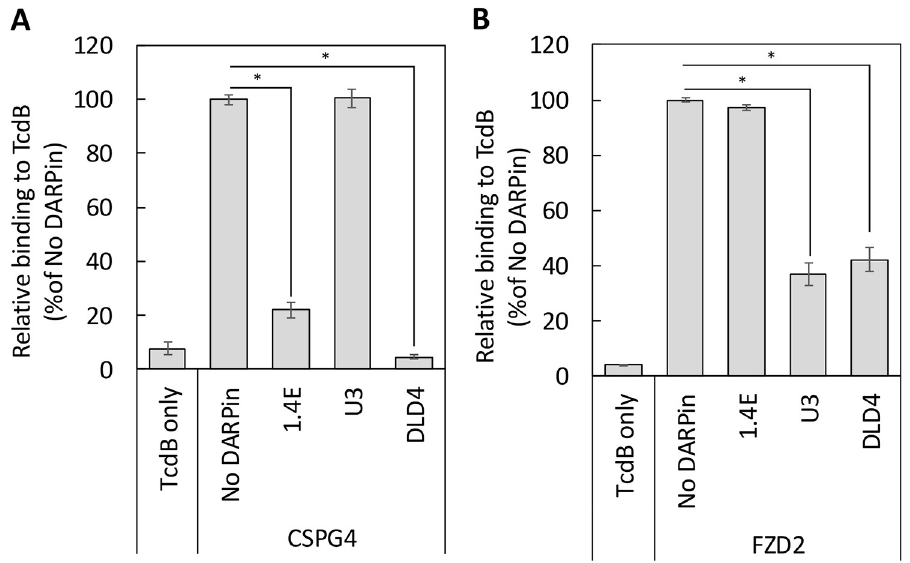
Fig 10. DARPin DLD-4 blocks the interaction between TcdB and its cellular receptors. ELISA plates were coated with TcdB VPI followed by treatment with the 1 nM of the extracellular domains of CSPG4 (A) or FZD2 (B) alone or in mixture with 250 nM of the indicated DARPins. The amount of TcdB-bound CSPG4 and FZD2 was detected using the respective antibodies. Data were normalized to each receptor binding to TcdB in the absence of DARPins (“No DARPin”). Both 1.4E and DLD-4 blocked the interaction between CSPG4 and TcdB, whereas U3 had no significant effect on the TcdB–CSPG4 interaction. Similarly, U3 and DLD-4 significantly blocked the interaction between FZD2 and TcdB but not 1.4E. Error bars represent the standard deviation of 3 independent experiments done in duplicate. � p < 0.005, t test. CSPG4, chondroitin sulfate proteoglycan 4; DARPin, designed ankyrin repeat protein; ELISA, enzyme-linked immunosorbent assay; FZD2, frizzled class receptor 2; TcdB, C . difficile toxin B.